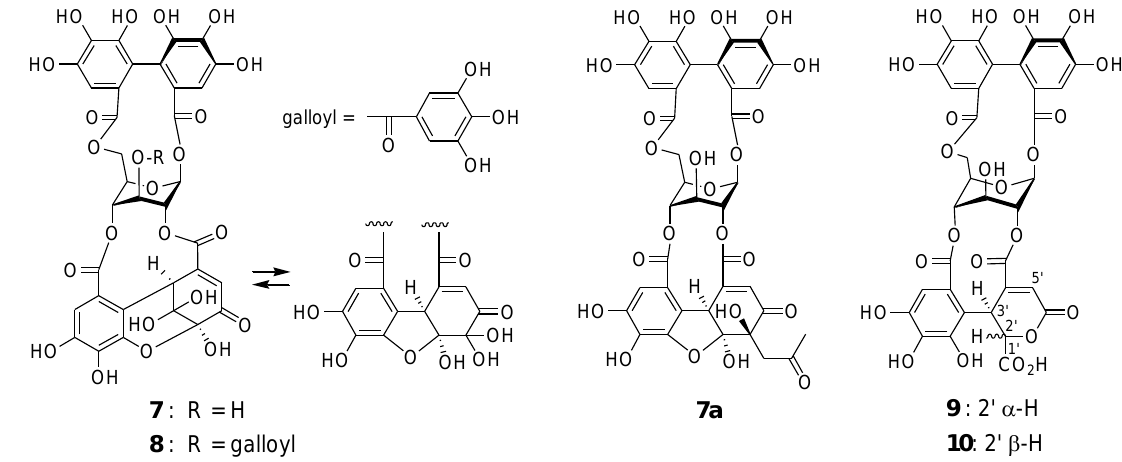
Figure 4. Structures of 7–10 and acetonyl derivative 7a .